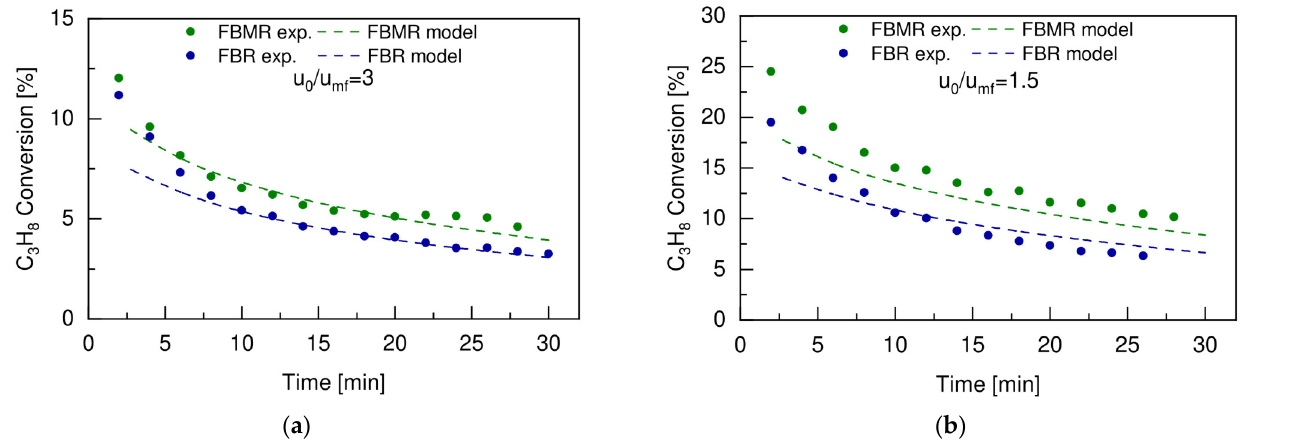
Figure 9. Propane conversion versus time obtained experimentally (dots) and with model simulation (dashed lines) for the FBR and the FBMR, working at 500 °C, 2 bar, with a feed composition of 30vol% C 3 H 8 -70 vol% N 2 , with ( a ) u 0 /u mf = 3 and ( b ) u 0 /u mf = 1.5.